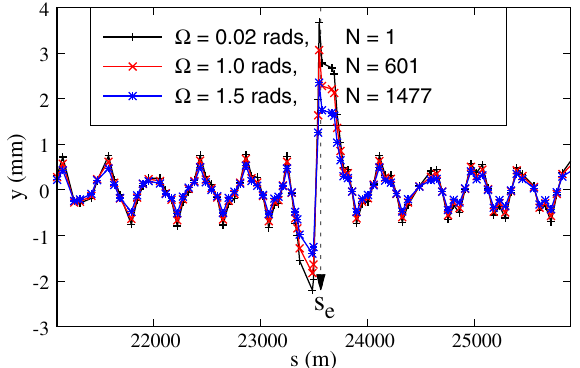
FIG. 3. Three average trajectories with different values of Ω . The larger the allowed phase range (determined by Ω ), the larger is N the number of trajectories involved in the construction of the average trajectory. All three average trajectories are in phase, and since the first one is a max trajectory, the other two are also max trajectories.